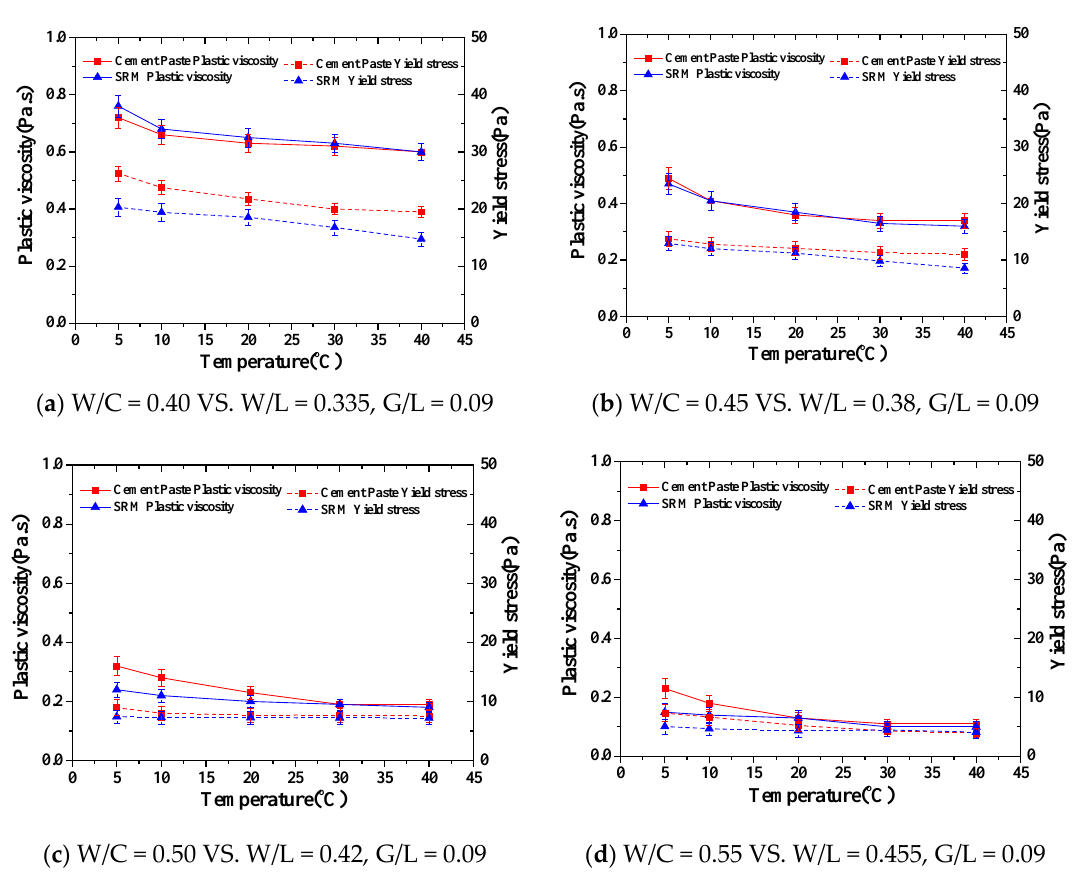
Figure 6. The comparison of the rheological properties of cement paste and standard reference materials.